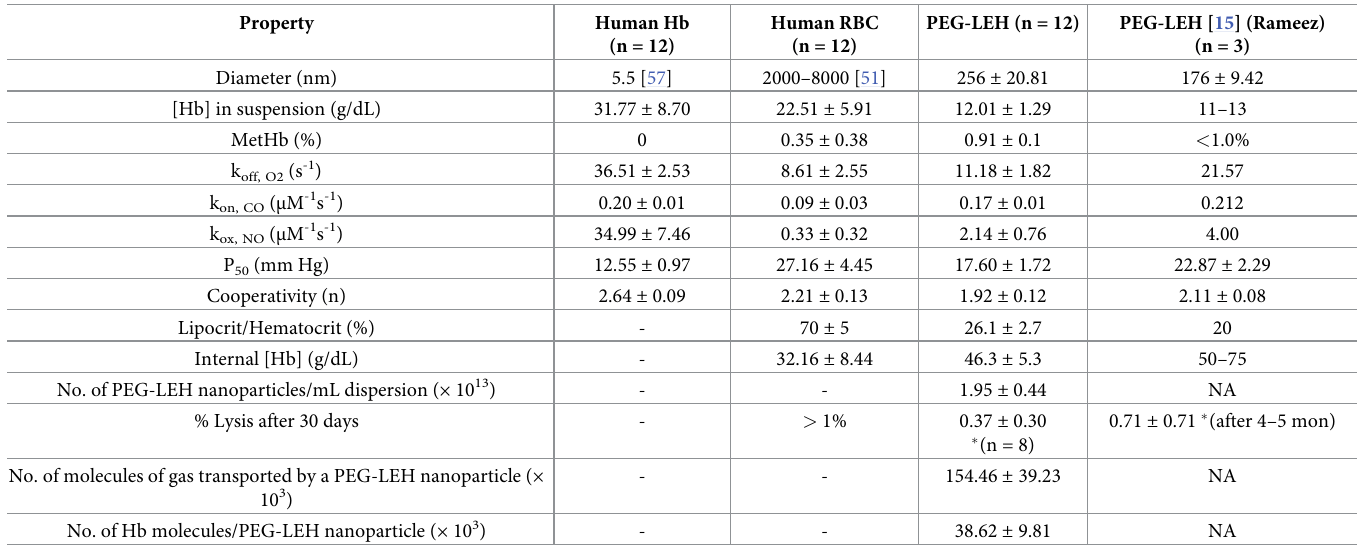
Table 1. Biophysical properties of PEG-LEH nanoparticles, RBCs and Hb.